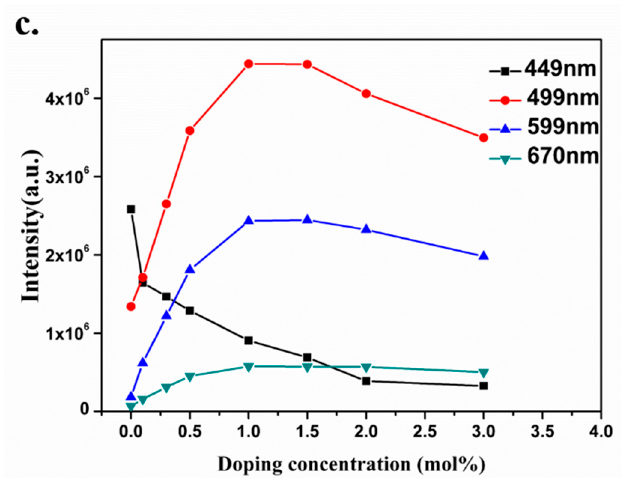
Figure 5. ( a ) Emission spectrum of Sr 2 Ca 0.99 WO 6 : 0.5 mol% Dy 3+ , 0.5 mol% M + (M + = Li + , Na + or K + ) under 310 nm excitation; ( b ) Emission spectrum of Sr 2 Ca (1 − 1.5x%) WO 6 : x mol% Dy 3+ (x = 0, 0.1, 0.3, 0.5, 1.0, 1.5, 2.0, 3.0) under 310 nm excitation. ( c ) The concentration-dependent emission intensity variations at 449